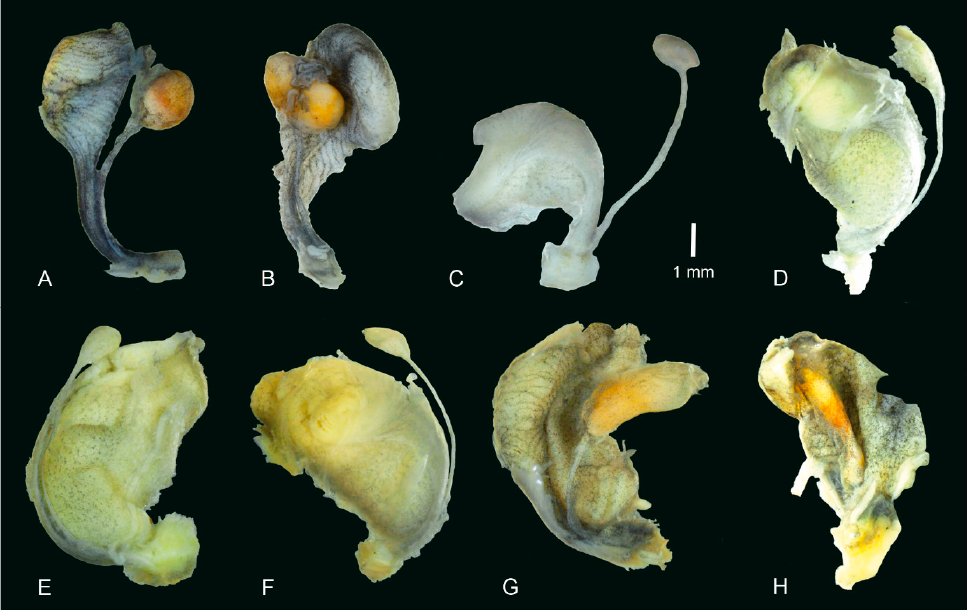
Figure 10. Variability of the form of the bursa copulatrix and the length of the bursa duct in Radix auricularia from Lake Baikal: ( A ) North of Buguldeyka, 2–3 m depth ( Radix Baikal 1); ( B ) North of Buguldeyka, 2–3 m depth ( Radix Baikal 2); ( C ) Ayaya Bay, 15 m depth ( Radix Baikal 26); ( D ) North of Cape Elokhin, 4–10 m depth ( Radix Baikal 3); ( E ) North of Cape Elokhin, 4–10 m depth ( Radix Baikal 4); ( F ) Maloye More, Shibeteyskaya Bay, 24–25 m depth ( Radix Baikal 11); ( G ) Listvenichnoe, 1–9 m depth ( Radix Baikal 12); ( H ) Listvenichnoe, 1–9 m depth ( Radix Baikal 13). Scale bar = 1